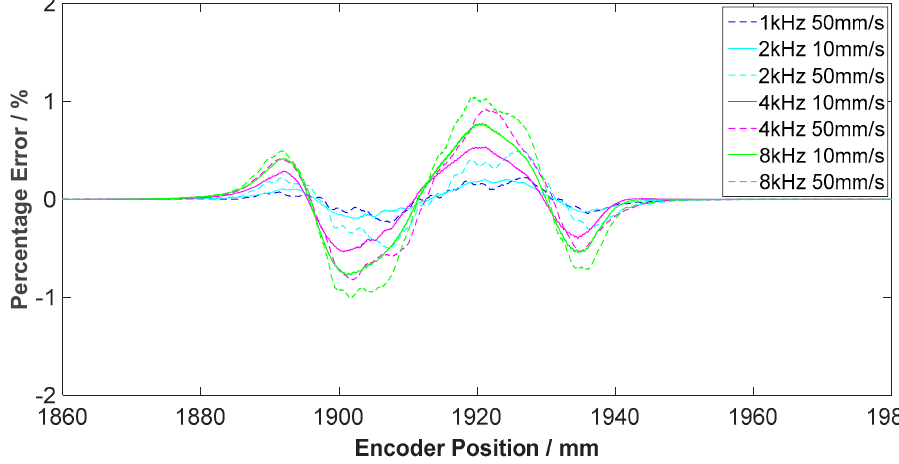
Figure 12. Percentage error plot obtained by applying interpolation on the 1 kHz 10 mm/s trajectory after delay compensation. Table 9. Percentage errors comparison before and after delay compensation was applied.